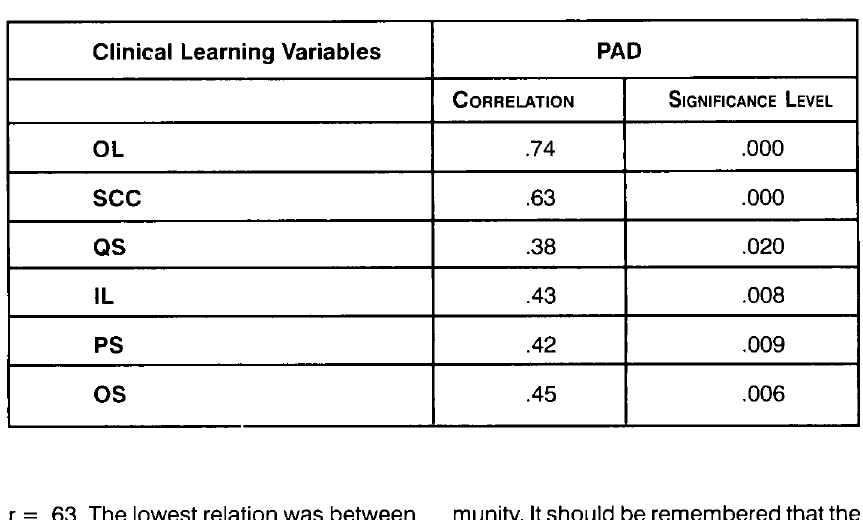
TABLE 3: Spearman Rank Correlation Between the Clinical Learn­ ing Variables and Personal and Academic Development